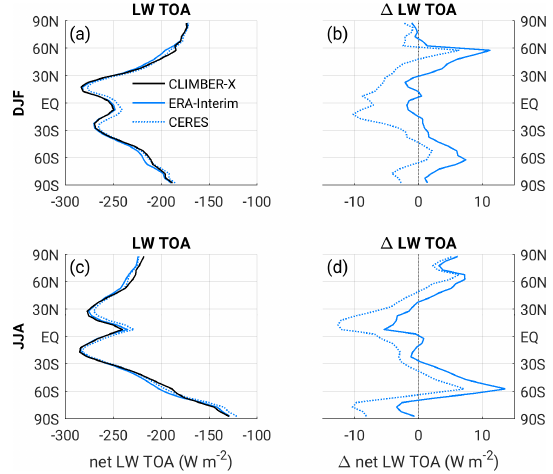
Figure A5. Zonal mean net longwave radiation at the top of the at- mosphere as computed by the CLIMBER-X radiation code in an of- fline set-up compared to ERA-Interim reanalysis (Dee et al., 2011) and CERES satellite observations (Loeb et al., 2018). Panels (a) and (b) are for December–January–February and panels (c) and (d) are for June–July–August. Panels (a) and (c) show absolute values, while panels (b) and (d) show model